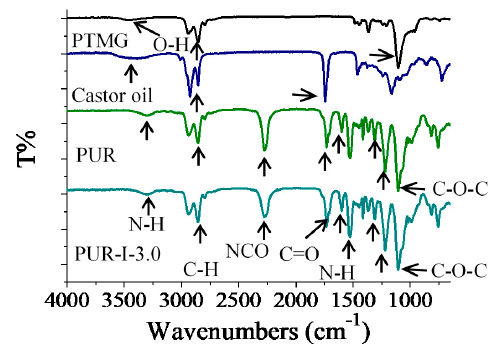
Figure 3. FTIR spectra of PTMG, castor oil and various cured PUR.